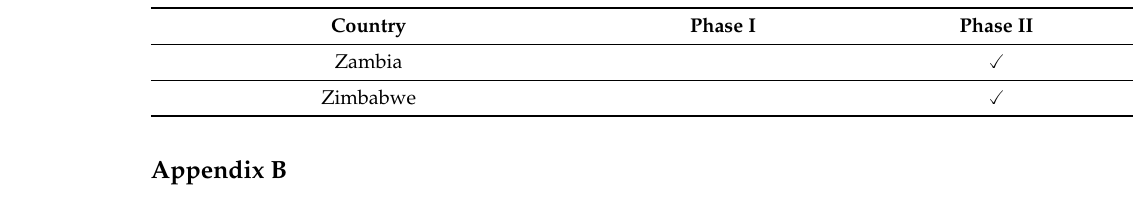
Table A2. Keywords used for data